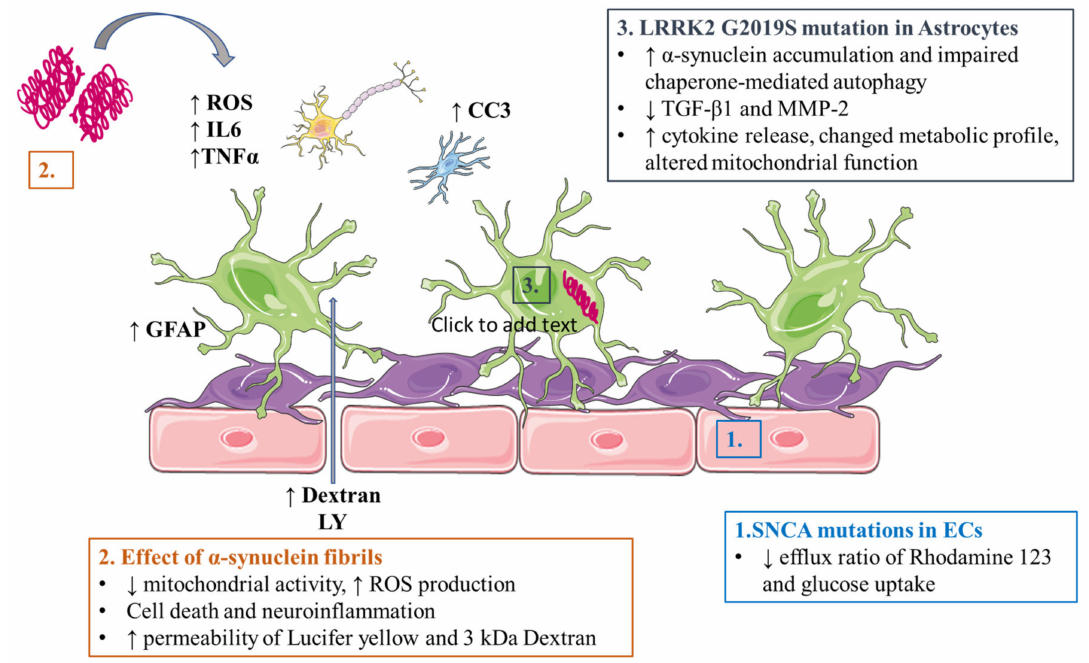
Figure 2. Schematic illustration of BBB dysfunction in PD based on iPSC-BBB